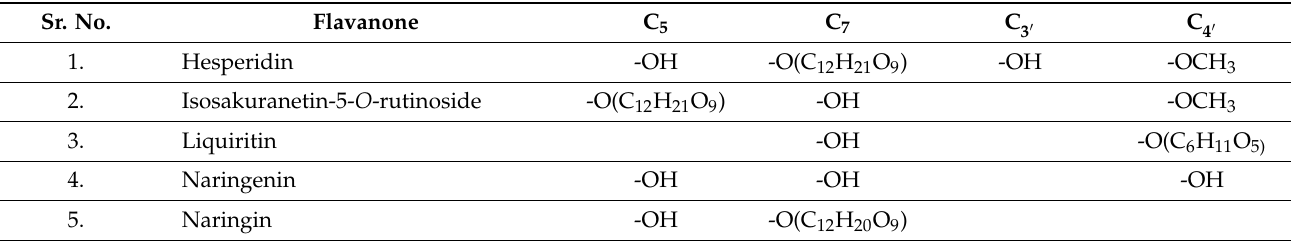
Figure 30. Skeleton of Flavanones. Table 3. Flavanones and their structure activity relationship.